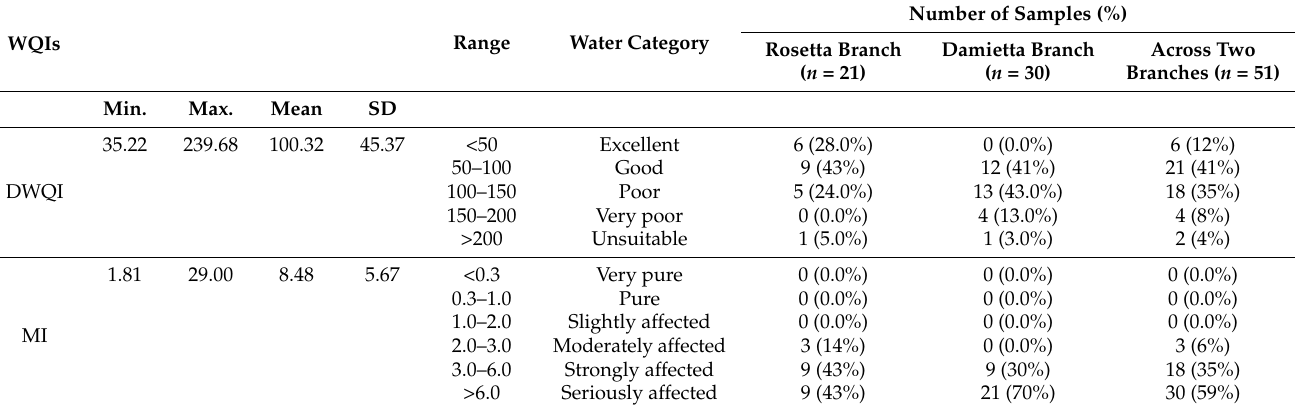
Table 5. Classification of the different water quality indices (WQIs).